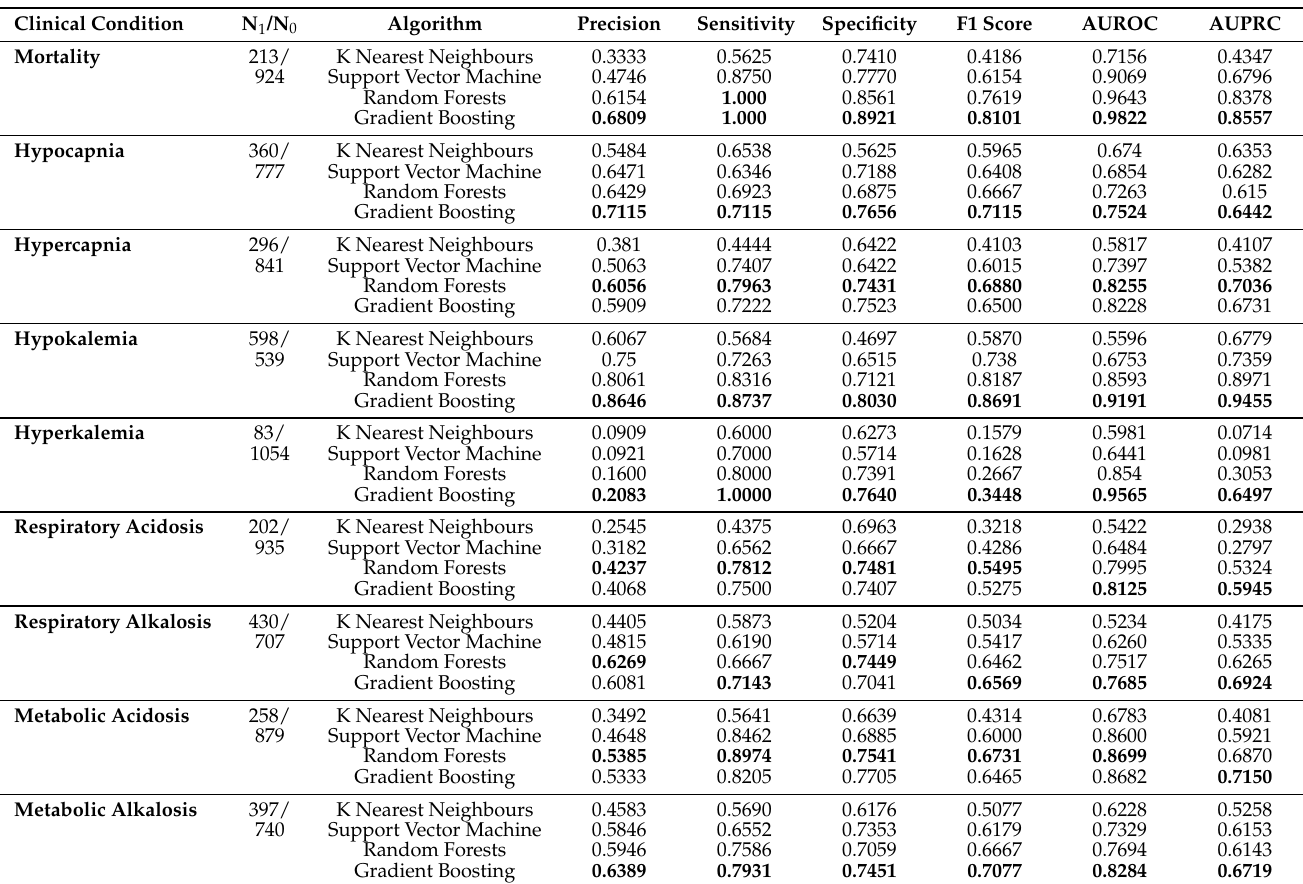
Table 3. Performance for the next-hour prediction on each clinical condition on the test